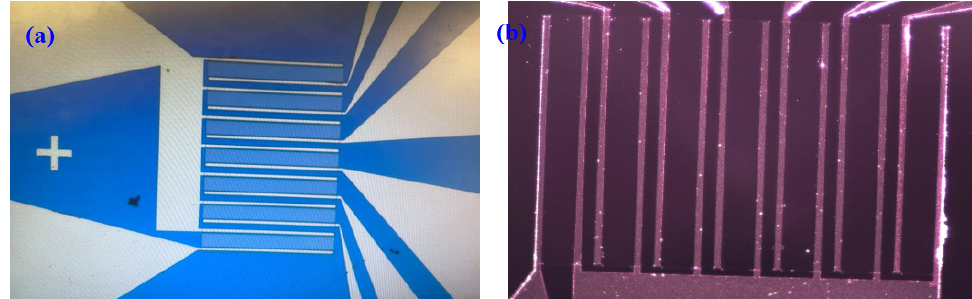
Figure 2. Microscopic images of the designed sensor. ( a ) The image was taken from the prob-station camera, showing the designed sensor with channels and the common source. ( b ) Close-up image under the optical microscope.